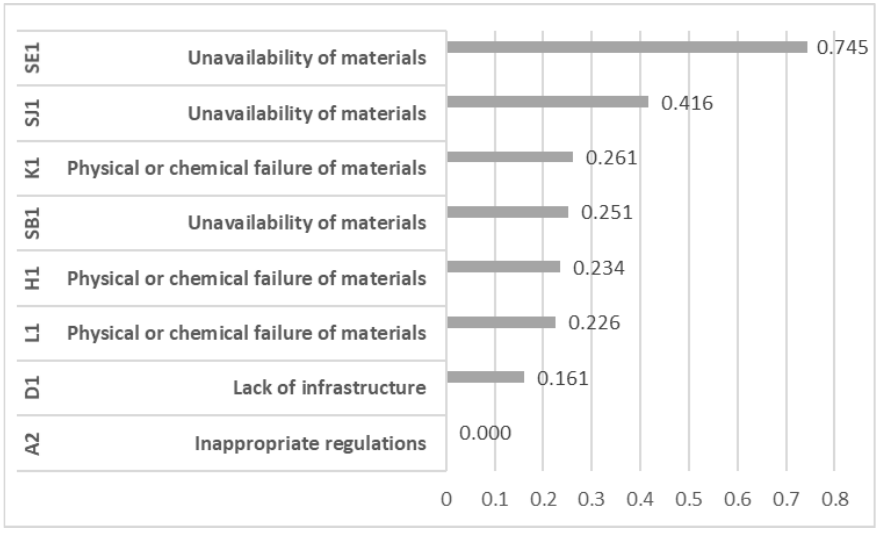
Figure 3. Sensitivity chart of costs (fixed cost increases).